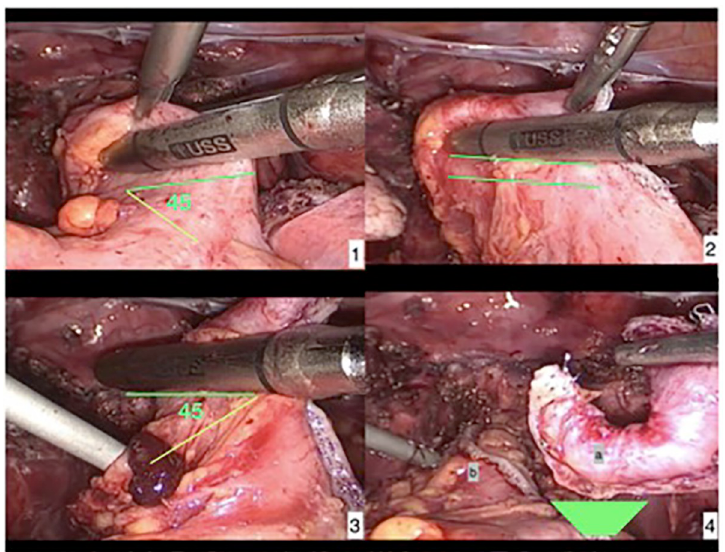
Fig 5. Surgical steps of the linear nodulectomy technique. 1- In the first step, the linear stapler was positioned 45 degrees from the axis of the intestinal lumen. 2- Next, consecutive staples (usually 2 or 3) were placed below the lesion and parallel to the axis of intestinal lumen. 3- To finish resection, the last stapler was positioned 45 degrees from the axis of the intestinal lumen to completely remove the endometriosis nodule. 4a- final aspect of the surgical specimen (inverted trapezoid shape). 4b- final aspect of the stapling line with a 29mm probe rectally